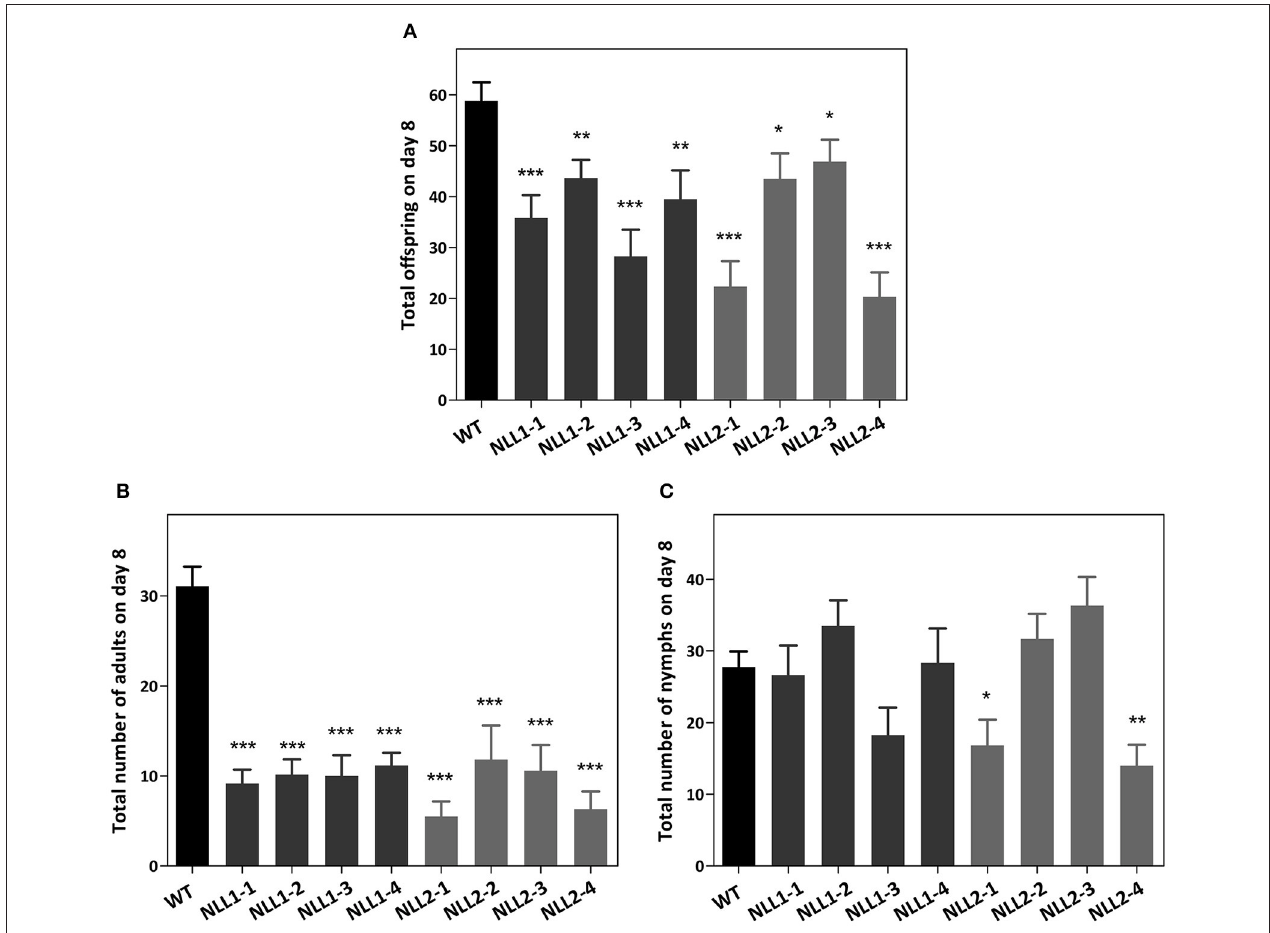
FIGURE 8 | Myzus persicae aphid performance in a non-choice test on wild type Arabidopsis plants and eight transgenic lines. The total offspring was counted after 7 days (A) . The number of adults (B) and nymphs (C) residing on the plants is also shown. Values are the means ± SE and represent the results from two biological replicates with six individual plants of every line in each of the replicates. Asterisks mark significant differences compared to wild type (* p < 0.05, ** p < 0.01, *** p <